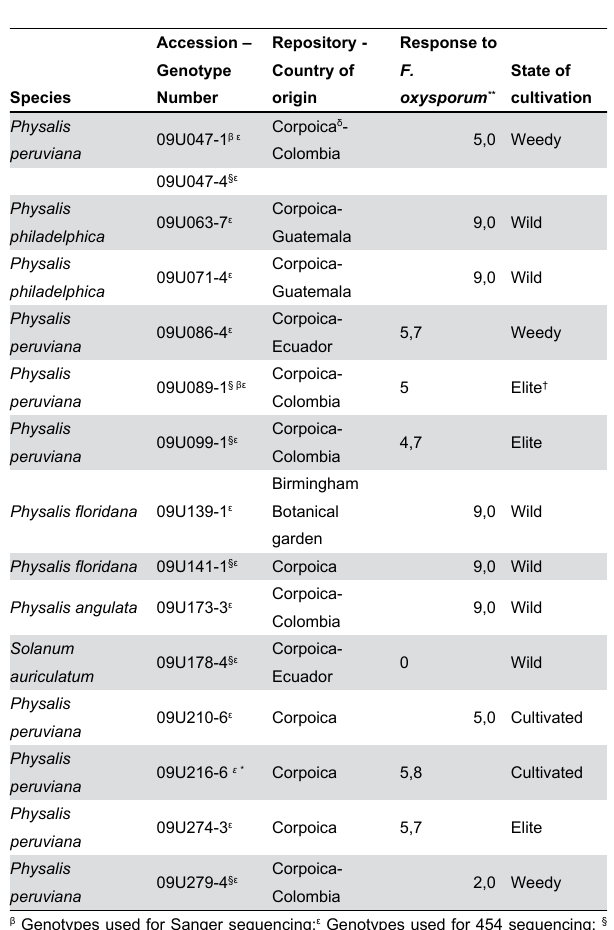
Table 1. Genotypes of Cape gooseberry and related taxa used in this study.